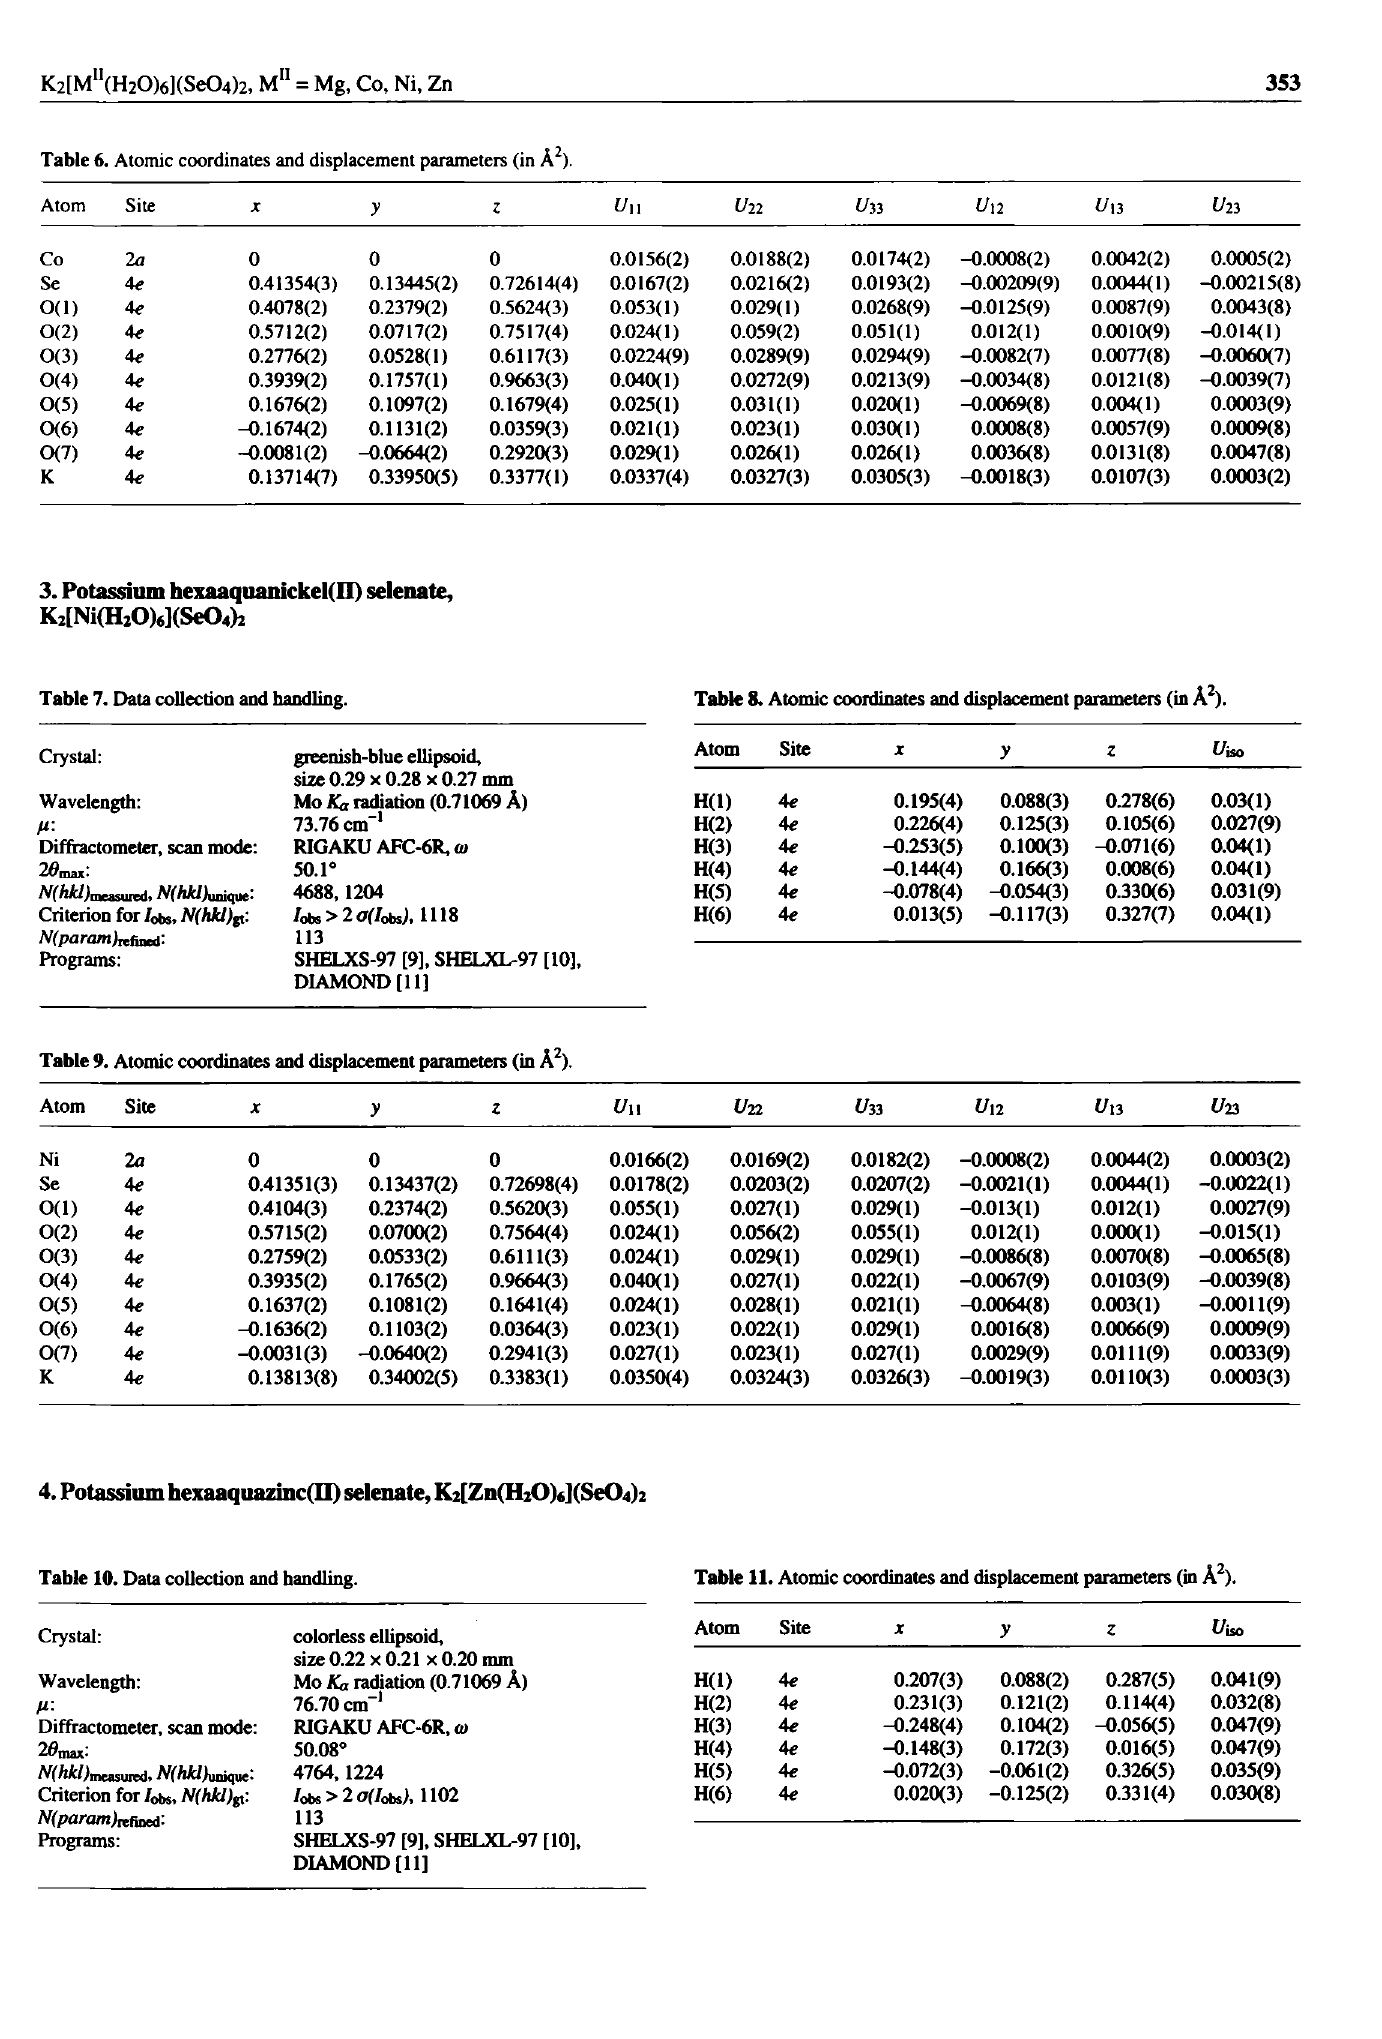
Table 6. Atomic coordinates and displacement parameters (in Â 2 ).